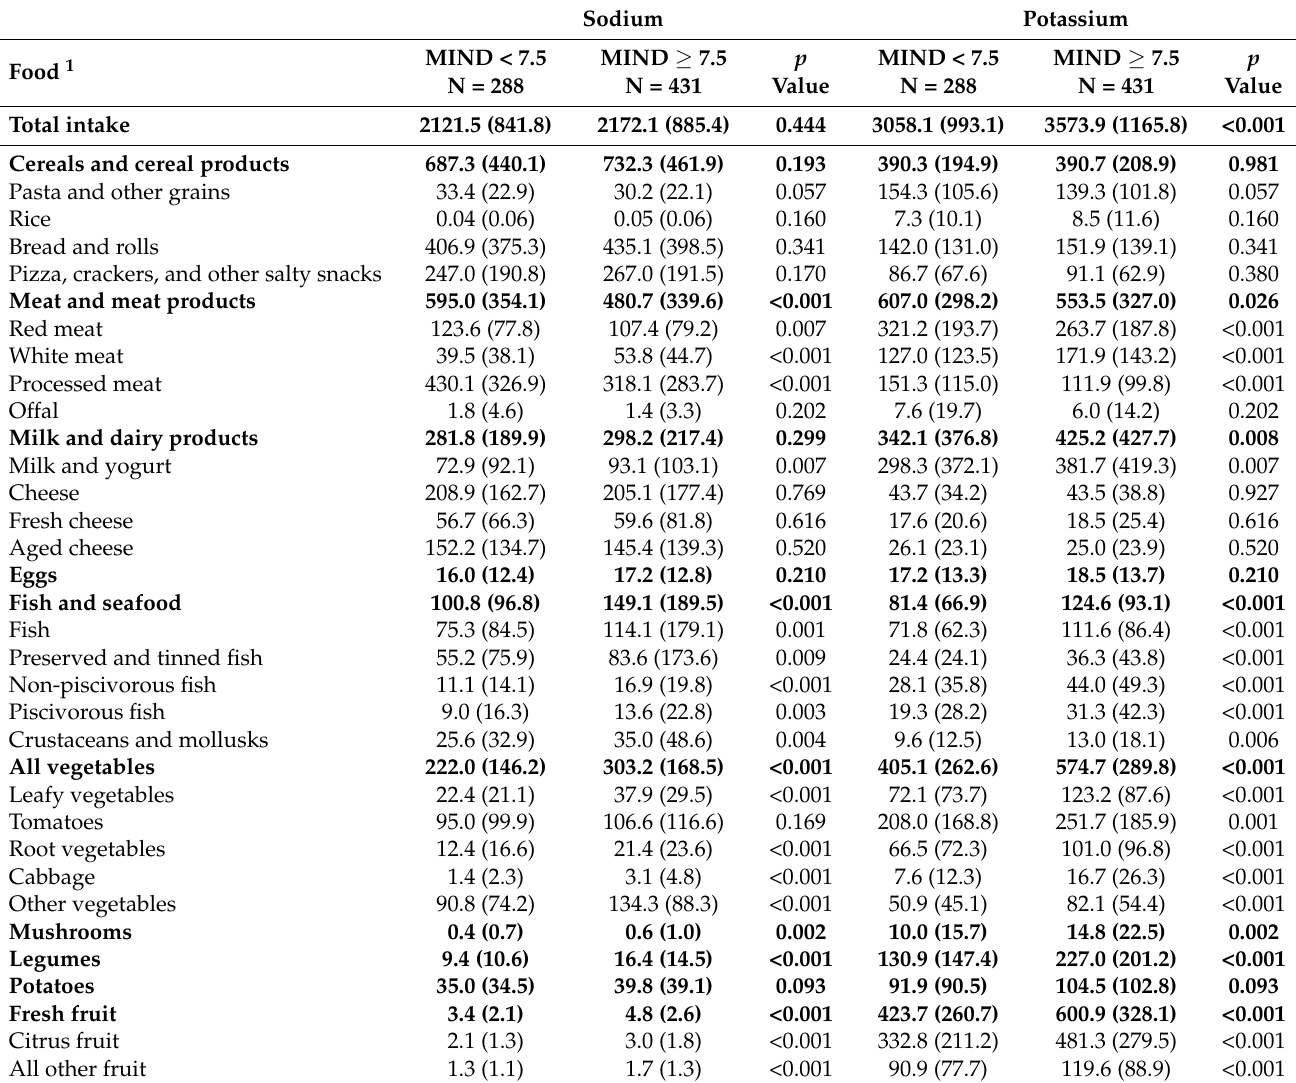
Table 6. Distribution of sodium and potassium daily dietary intake below (<7.5) and above ( ≥ 7.5) the median adherence to the Mediterranean–DASH Diet Intervention for Neurodegenerative Delay (MIND) (in mg/day). Mean, standard deviation, and p values from the t -test of differences between means are